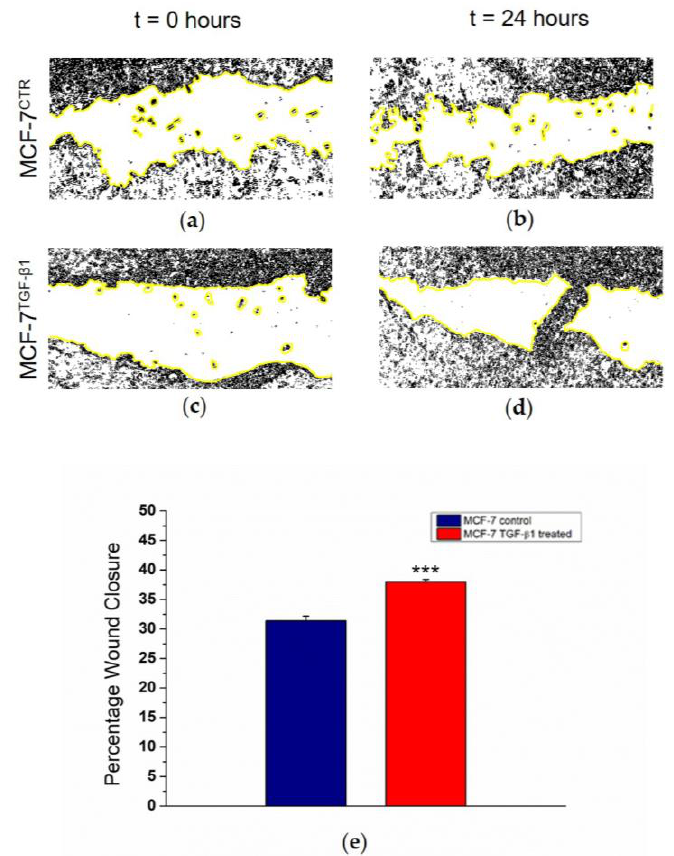
Figure 5. Wound healing assay experiments at two time points (0 and 24 h) on MCF-7 CTR ( a , b ) and MCF-7 TGF-β1 ( c , d ). The images were acquired in bright field by using a 20× objective (Zeiss) mounted on an Axiovert microscope (Zeiss) and processed by a specific tool of ImageJ software. The yellow lines indicated the boundary of the scratch. The closure percentage ( e ) was calculated as a percentage rate of the area remaining uncovered by the cells ( t = 24 h) with respect to the area immediately after scratching ( t = 0).